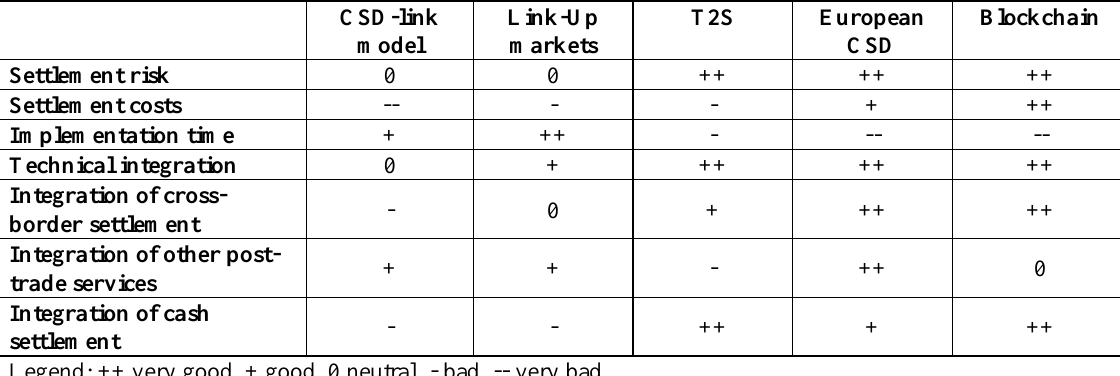
Table 9. Modified Schaper’s comparison of securities settlement